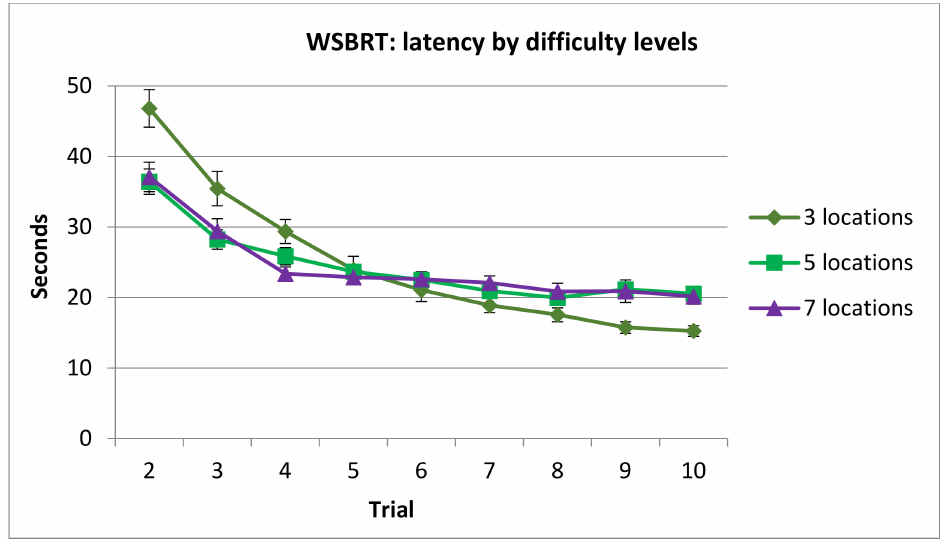
Figure 7. Time spent completing each trial of each difficulty condition in the WSBRT. Note that trial 1 was removed from analysis since performance was at random. (Mean ± SEM).